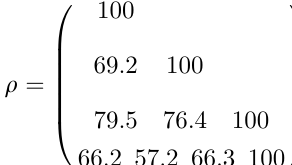
Table 1. Equivalently weighted portfolio risk decomposition. Alongside assets a 1 , ... , a m